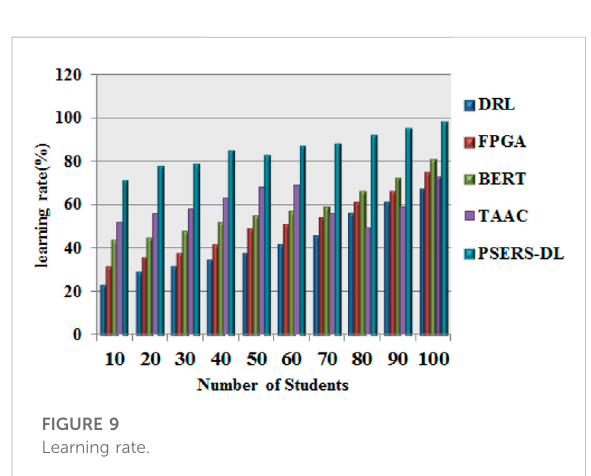
FIGURE 9 Learning rate.